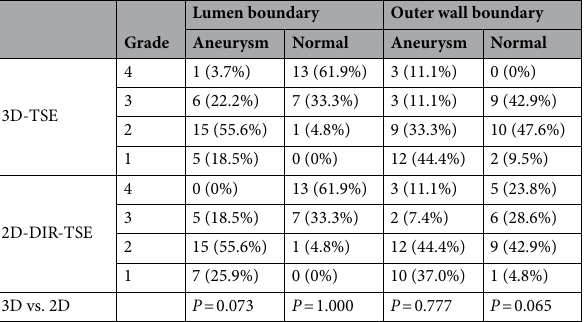
Table 2. The summary of visual grading: Aneurysmal region, n = 27; Normal region, n = 21. 3D-TSE three- dimensional turbo spin-echo, 2D-DIR-TSE two-dimensional dual inversion-recovery turbo